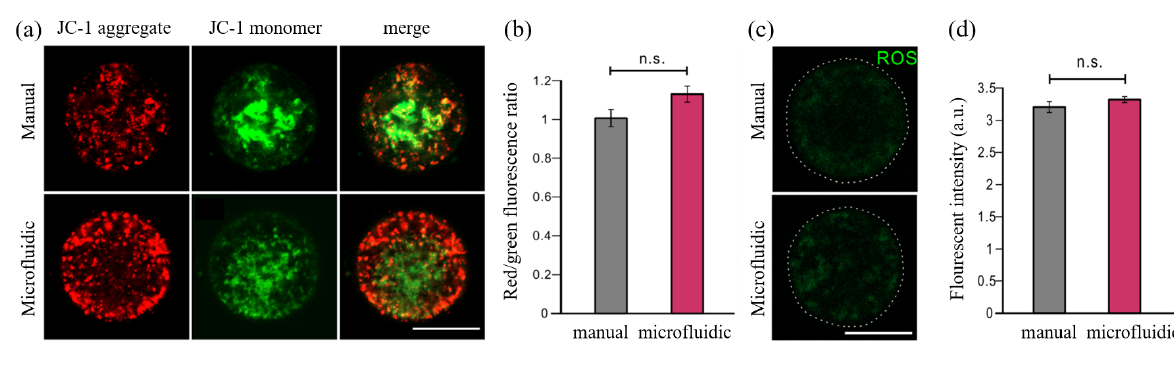
Figure 10. JC-1 staining and ROS level measurement of the oocytes. ( a ) The MMP level of thawed MII oocytes was measured by JC-1 staining. ( b ) The red/green fluorescence ratio of oocytes was quantified between manual and microfluidic groups. ( c ) The ROS level of thawed GV oocytes between manual and microfluidic group. ( d ) The ROS levels were measured and quantified in two groups. The students’ t -test was used to compare the difference in two groups. n.s. means no significant difference between two compared groups. Scale bar is 50 µ